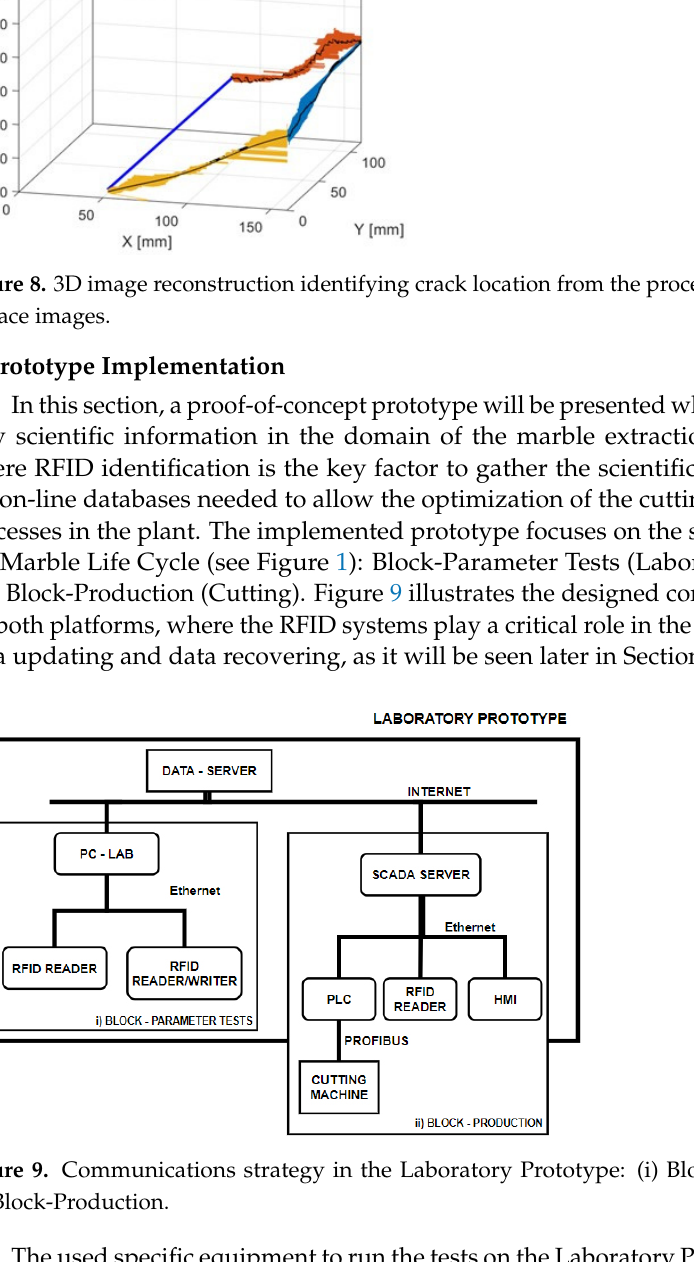
Figure 7. Post-processing data structure from image tests.